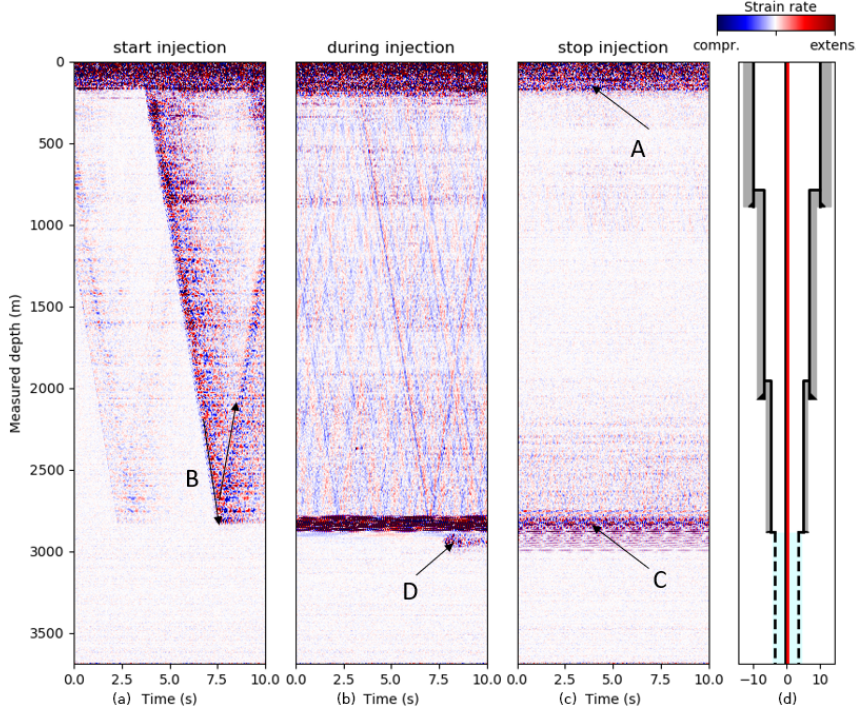
Figure 3. DAS raw data examples over the scope of the cold-water injection phase for (a) the onset of fluid injection, (b) ongoing injection and (c) termination of fluid injection. Blue colors show relative compression and red colors relative extension. The color ranges are the same for all subplots.